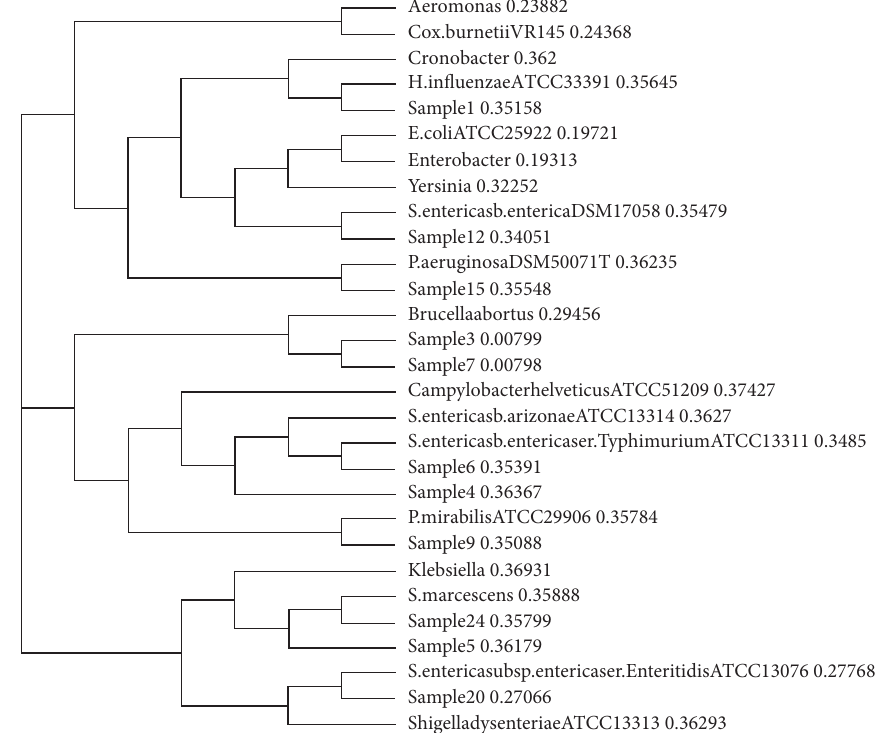
Figure 3: Phylogenetic tree generated with multiple sequence alignment using 16S rRNA gene partial sequences of the study isolates and type strains. “Sample” is synonymous to “isolate” in the text (e.g., sample 1 is the same as isolate